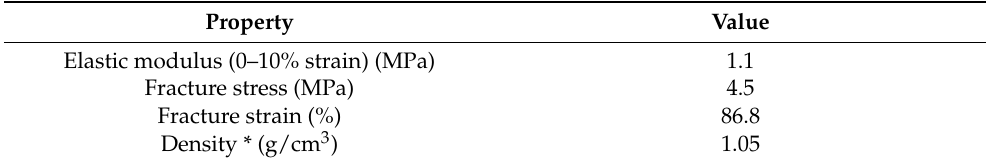
Table 6. Properties of the silicone rubber material.